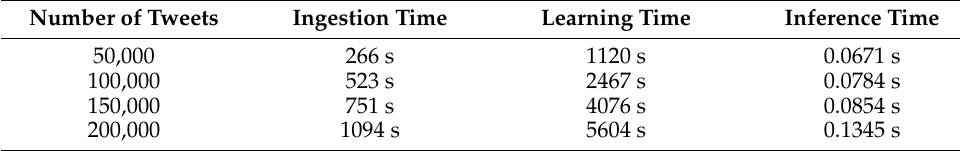
Table 1. The elapsed time for ingesting, learning, and inferencing tweets. Number of Tweets Ingestion Time Learning Time Inference Time 50,000 266 s 1120 s 0.0671 s 100,000 523